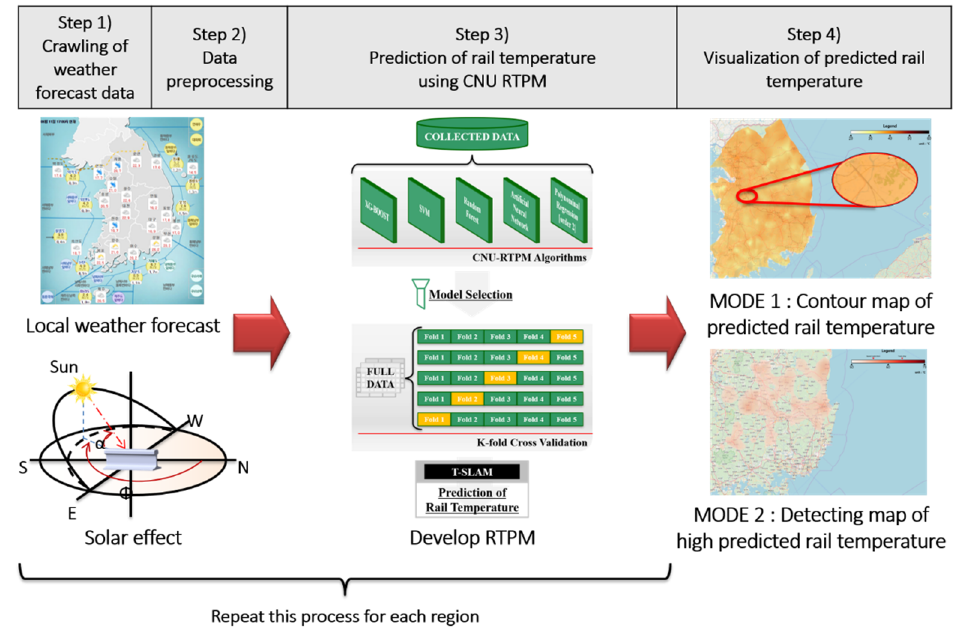
Figure 4. Framework of mapping the local rail-temperature prediction.